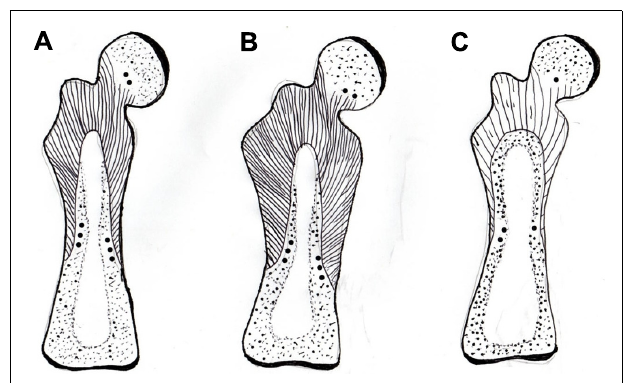
FIGURE 4 | Diagram of a mature rat femur showing the gross configuration of the expansive CIII/CVI-rich proximal domain of Sharpey fiber bone (striped area), terminating in CII/CVI-rich “anchors” (round dots), (A) in a normal control, (B) expanded in response to voluntary running exercise, and (C) contracted in response to OVX. After Luther etal. (2003) and Saino etal.